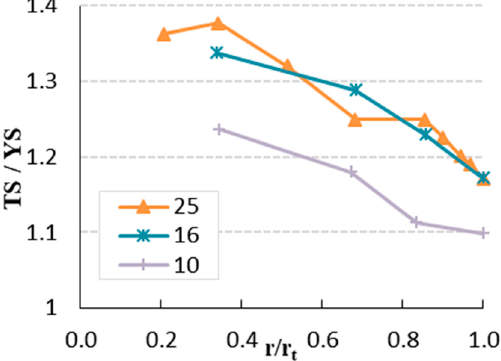
Figure 7. The yield and tensile strengths of the steel bars φ 25A, φ 16A, φ 10A.